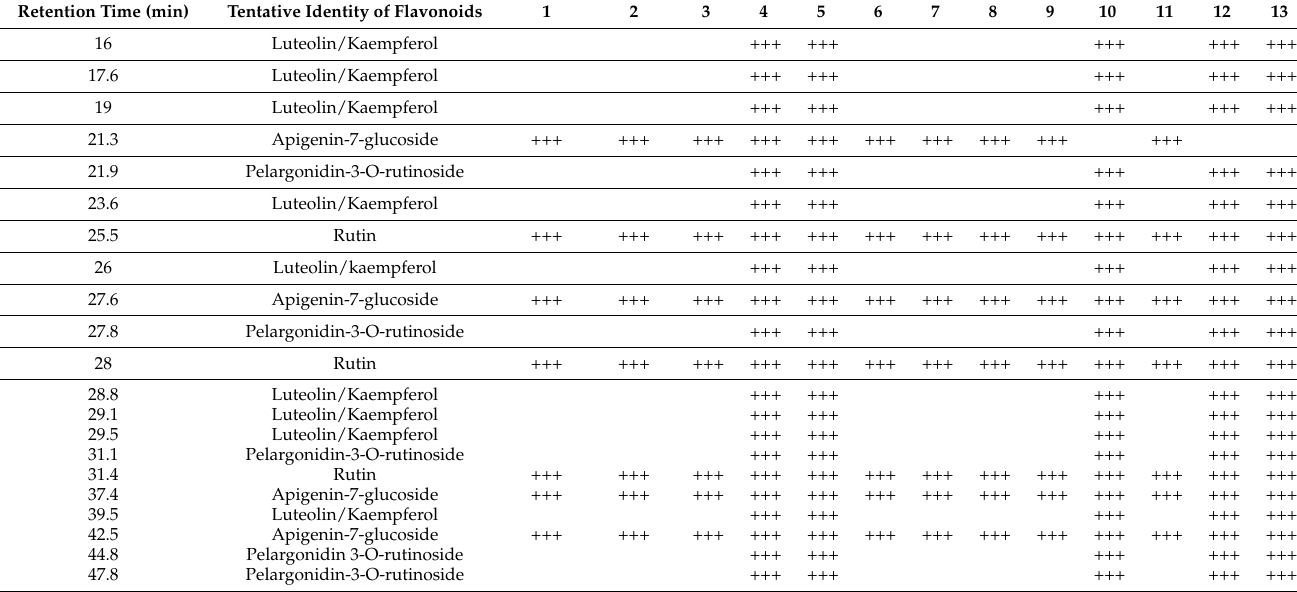
Table 6. Main tentative flavonoids in S. patula according to their retention time. Numbers 1–13 correspond to the identification of the studied materials collected in Table 1. +++ =